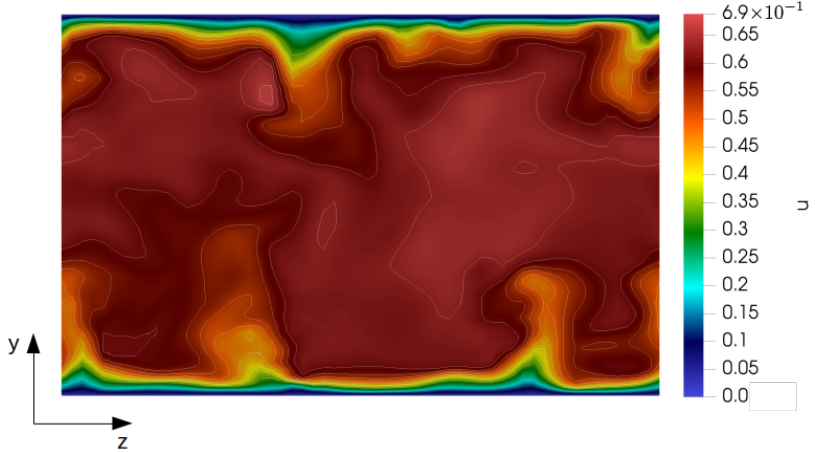
Figure 21. Instantaneous velocity contour in streamwise direction at yz plane for case with high particles mass fraction particles. Plane located at the streamwise channel half length.